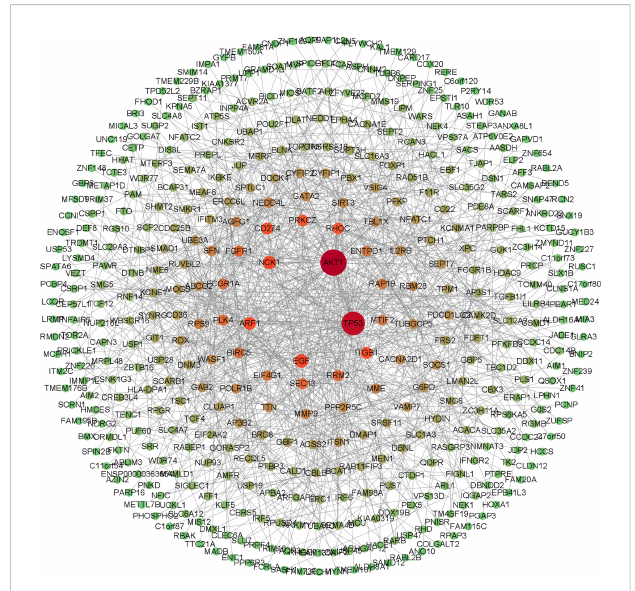
FIGURE 3 PPI regulatory network diagram. The network color is the progressive distribution from green to red, and the node size is the progressive arrangement from small to large. The redder the node and the larger, the greeter the degree of the node, and the greener the node, the smaller the degree of the node.